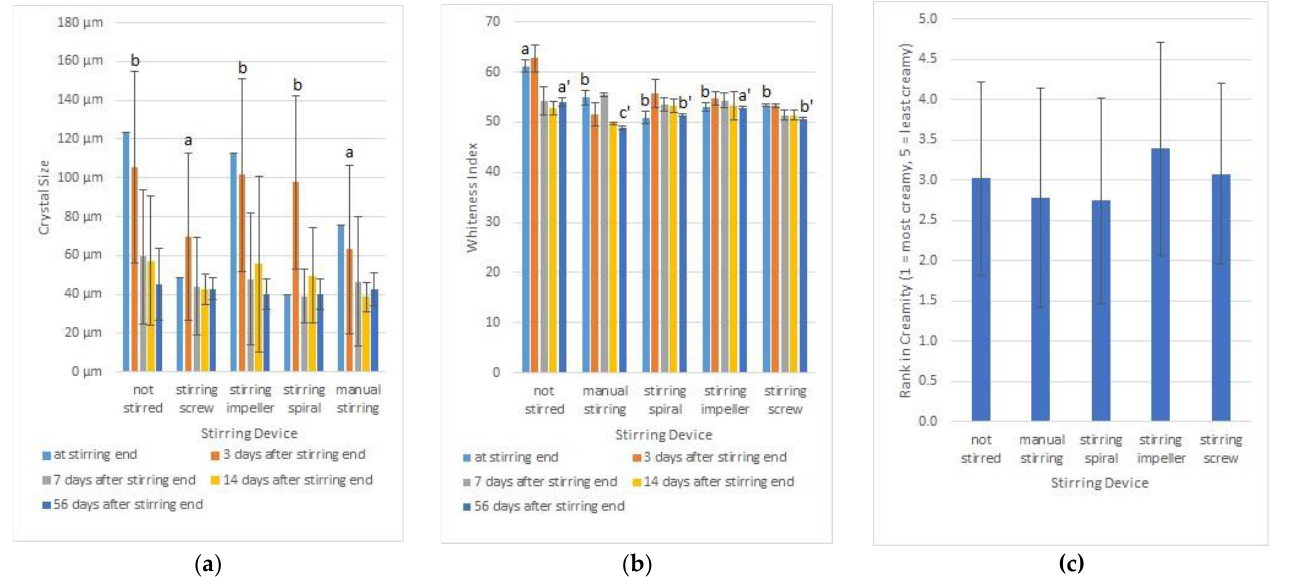
Figure 1. Influence of stirring device on the creaminess of honey. (a, b, a’, b’, c’ denote groups of significantly different samples.) ( a ) Mean and standard deviation of the size of the 10 largest crystals on different days. ( b ) Mean and standard deviation of whiteness index of the honey on different days. ( c ) Mouthfeel of the honey, tested by 54 trained sensory testers by ranking test after 56 days storage (average rank and standard deviation).